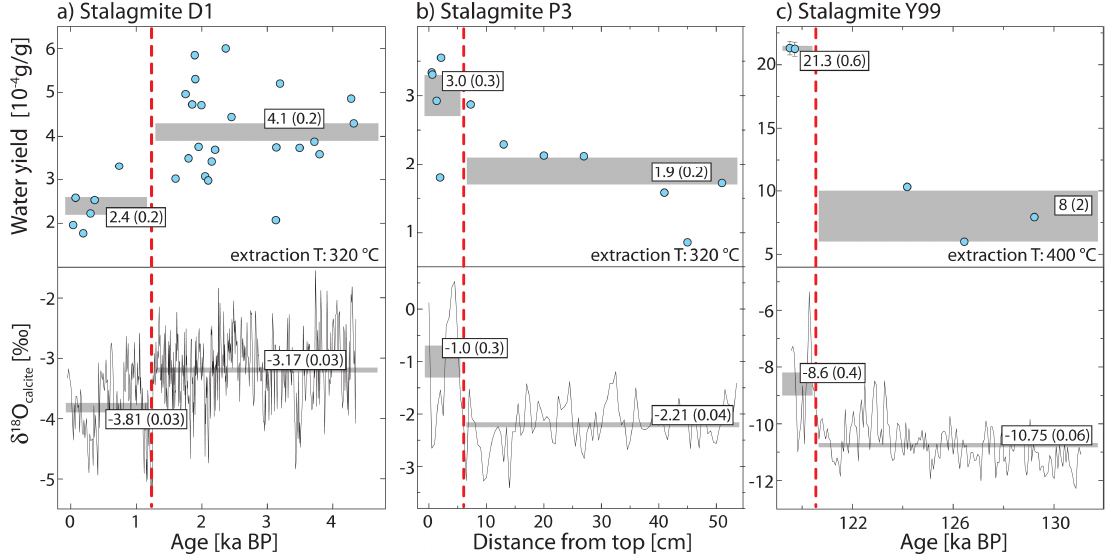
Fig. 7. Water yield and oxygen isotopic compositions of stalagmite D1 (a) , P3 (b) , and Y99 (c) plotted as functions of sample age (D1, Y99), and distance from top (P3). Dashed red lines refer to the major regime shift points as defined from the δ 18 O calcite data using STARS (Rodionov, 2004). Numbers in squares represent mean values with standard errors of the means of the data points on both sides of the major regime shift points, respectively. The means are also visualized as grey squares in the plots, the height of the squares corresponding to the standard errors of the